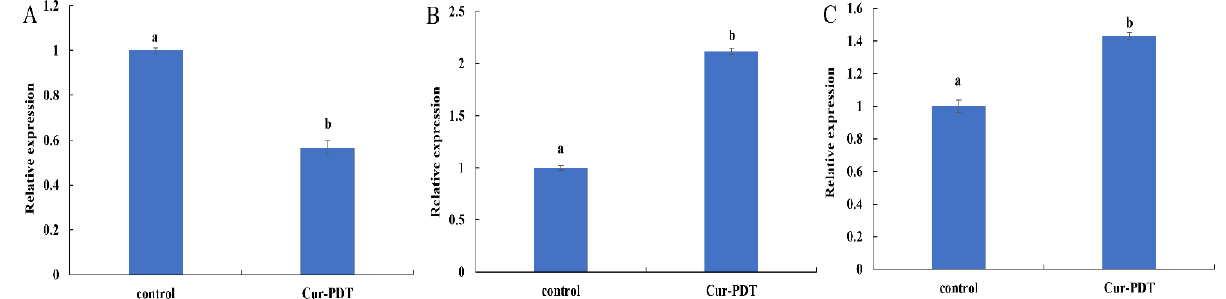
Figure 6. The expression levels of TasA ( A ), RecA ( B ) and UvrA ( C ) mRNAs of B. subtilis with 2.5 μmol/L curcumin -mediated PDT treatment. Different lowercase letters indicate the significant differences ( p < 0.05).